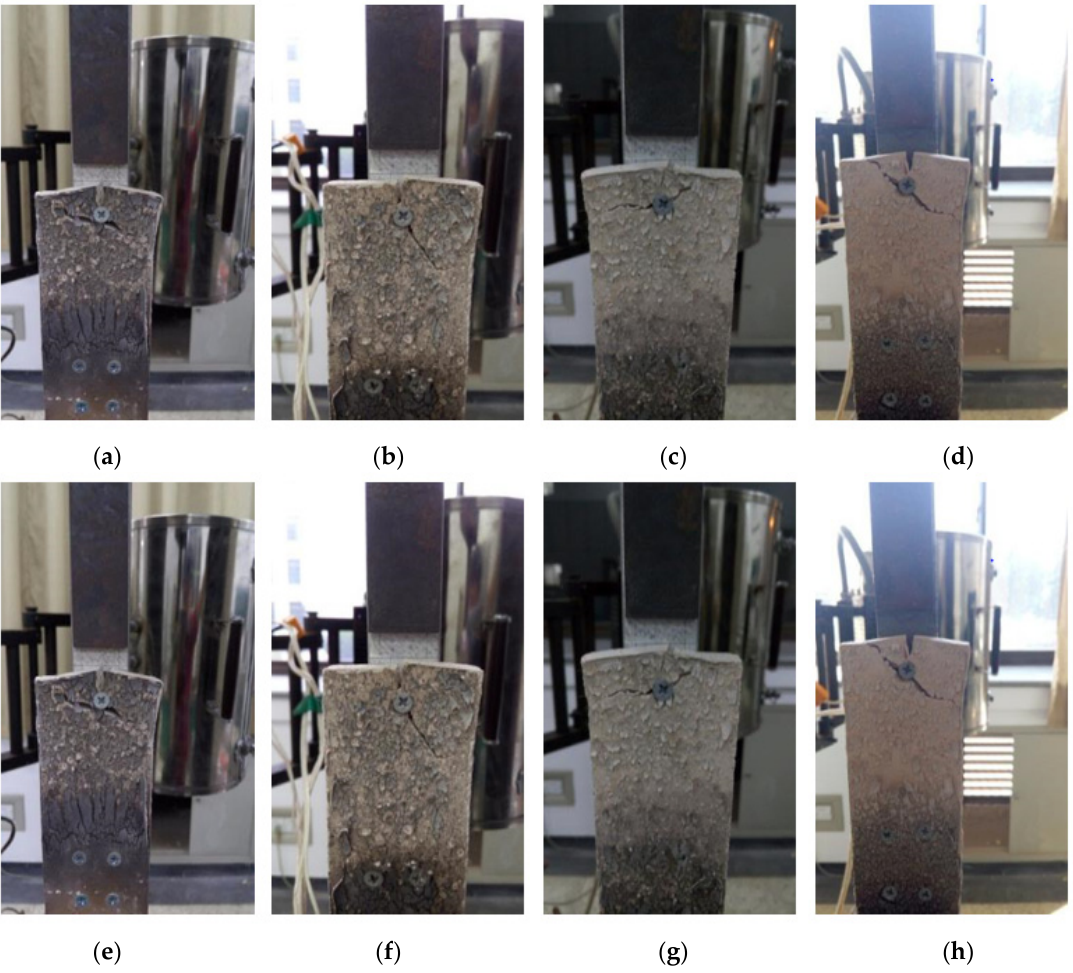
Figure 9. Failure modes of GPB15S series at elevated temperatures: ( a ) 150 °C; ( b ) 200 °C; ( c ) 250 °C;